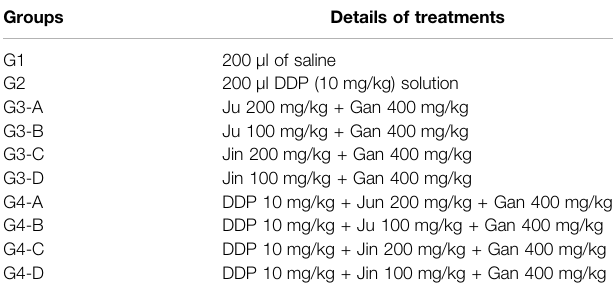
TABLE 2 | Methods of HPLC on Ju ( λ = 348 nm).